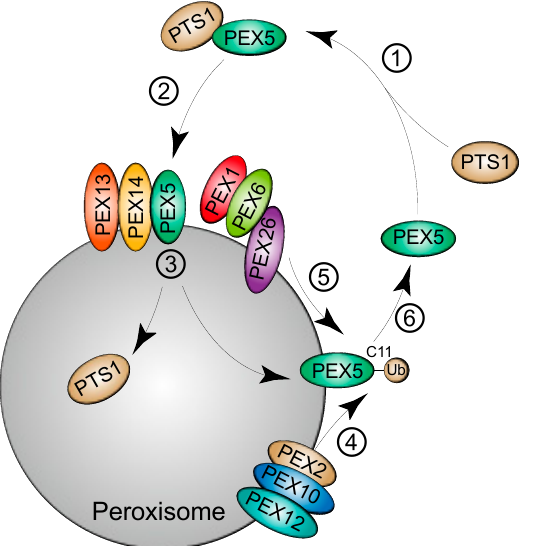
Figure 1. Model for the import of peroxisomal matrix proteins. PTS1-containing cargos are synthe- sized in the cytoplasm and recognized by the receptor PEX5 ( 1 (cid:13) ). PEX5 interacts with the peroxisome- associated docking proteins PEX13 and PEX14 and transports the cargos to the matrix ( 2 (cid:13) ). After the release of the cargos ( 3 (cid:13) ), PEX5 is recycled back to the cytoplasm for the next round of import ( 4 (cid:13) 5 (cid:13) 6 (cid:13) ). Extraction of PEX5 from peroxisomes depends on the monoubiquitination of PEX5 at C11, which is catalyzed by the E3 ligase complex (PEX2, PEX10, and PEX12) ( 4 (cid:13) ). The AAA complex (PEX1-PEX6-PEX26) facilitates the extraction process ( 5 (cid:13)